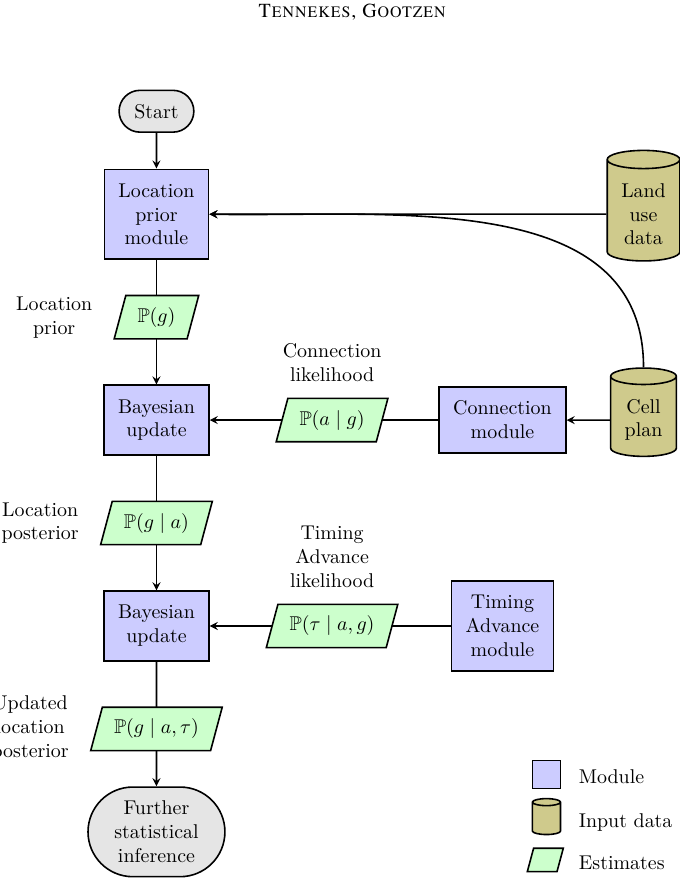
Figure 6: A modular framework for modelling location